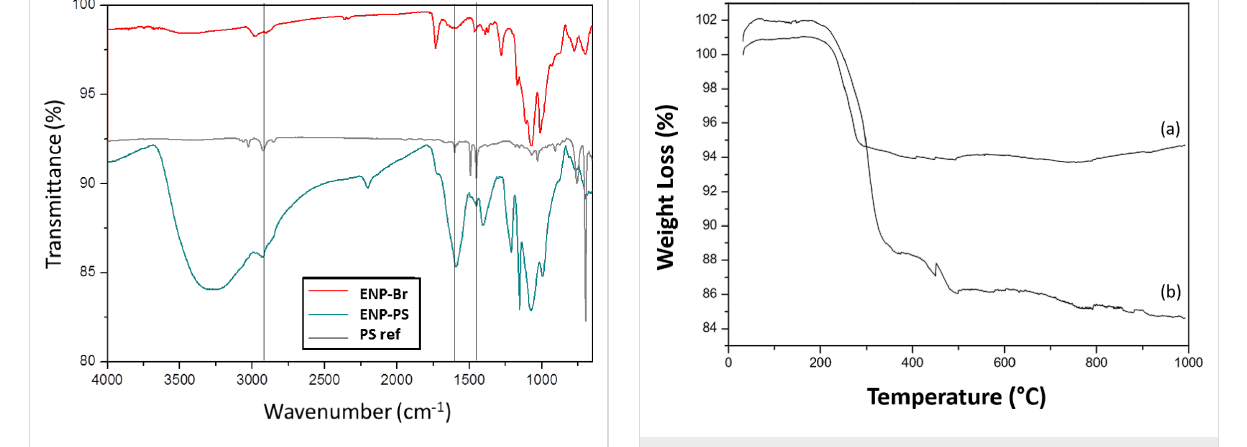
Figure 4: TGA curves of (a) ENP-PS-18 and (b) ENP-PS-20. than those of PMMA in ENP-PMMA-1 and ENP-PMMA-3 [15], meaning that PS collapses less than PMMA. This is doubtful due to the presence of aromatic